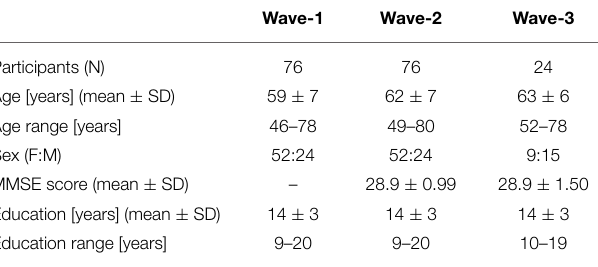
TABLE 1 | Demographic characteristics of the